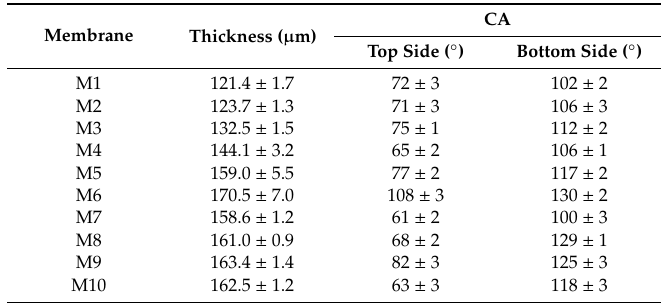
Table 4. Thickness and contact angle (CA) of the prepared